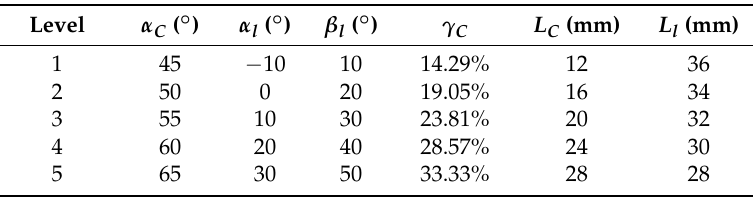
Table 3. Geometric parameter